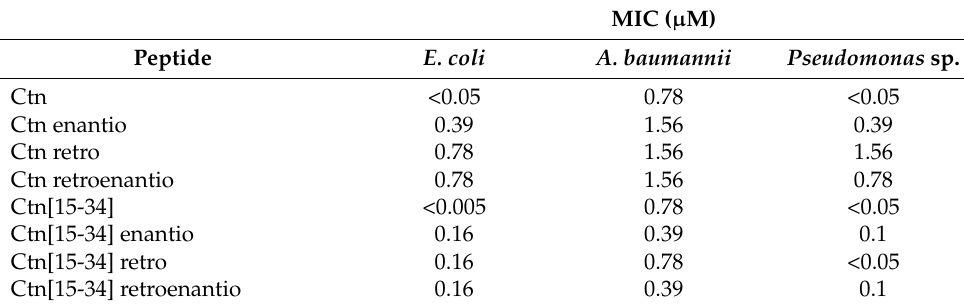
Table 2. Minimal inhibitory concentrations (MICs) of Ctn, Ctn[15-34], and their topoisomers against Gram-negative bacteria.